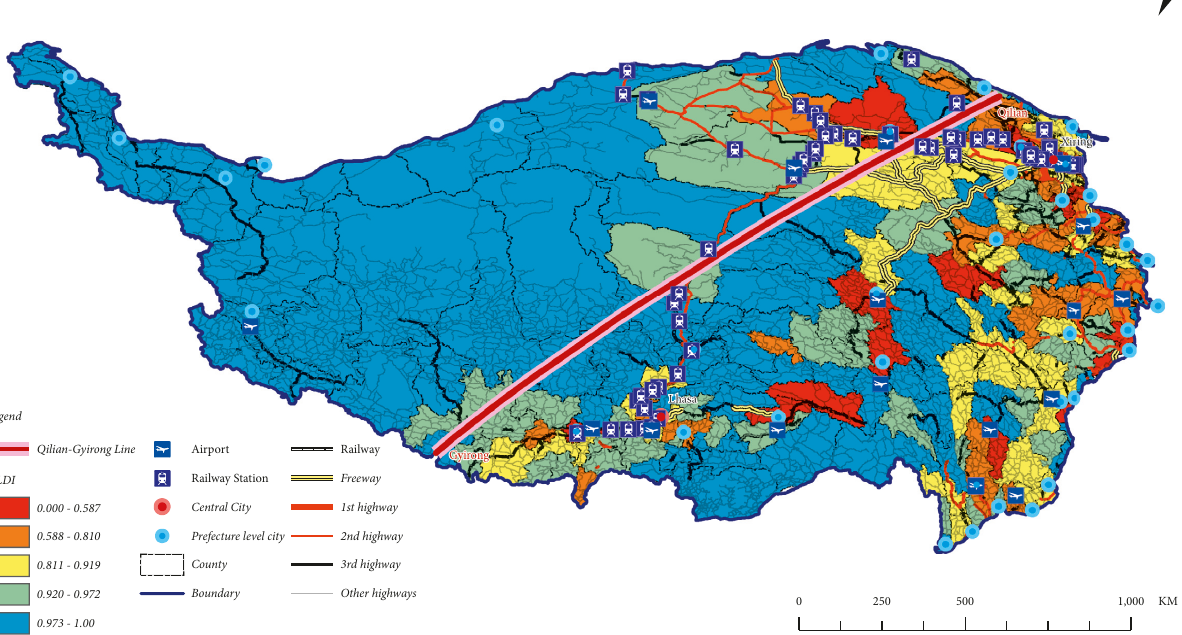
Figure 16: Spatial distribution of NLDI (showing the “Qilian-Gyirong